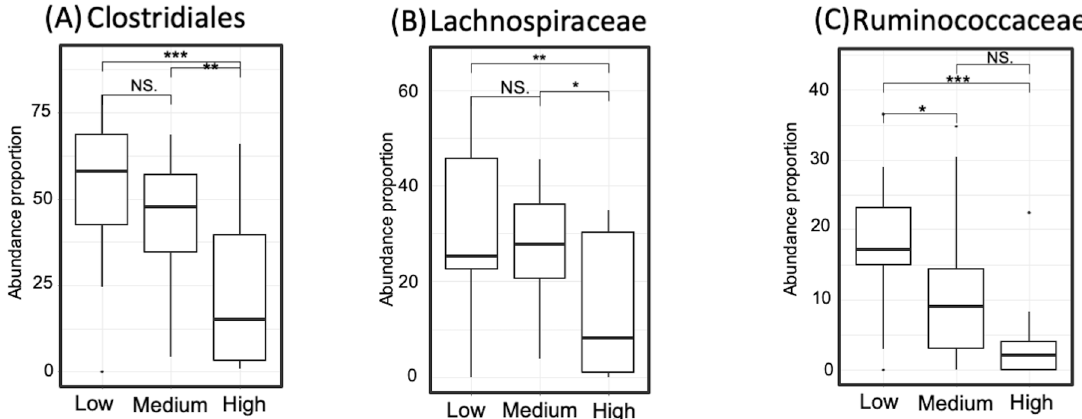
Figure 8. Proportion of taxa that occurred abundantly in the low-gamma-aminobutyric acid (GABA) group including Clostridiales (Panel A ), Lachnospiraceae (Panel B ), and Ruminococcaceae (Panel C ). Significance codes: < 0.001 ***, < 0.01 **, < 0.05 *, < 0.1 “NS”.